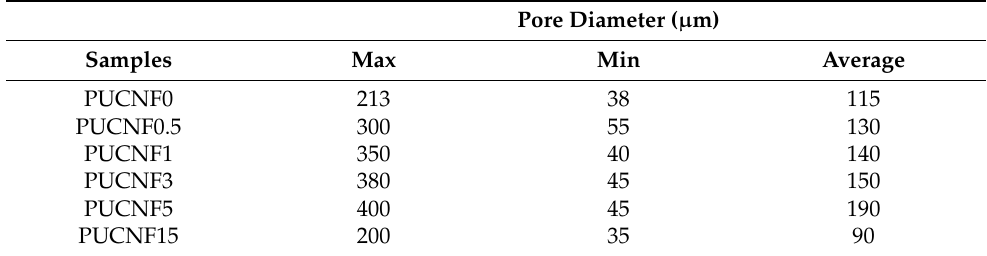
Table 1. Maximum, minimum, and average pore diameter of all the PUCNF foams.